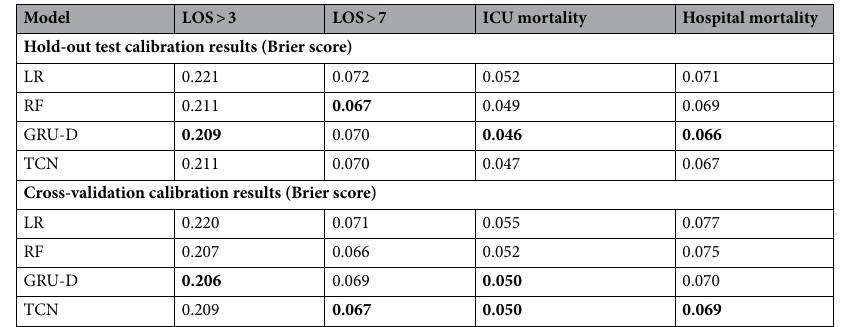
Table 3. Model calibration comparison using Brier scores for both hold-out validation and cross-validation. Inner-task comparison demonstrates similar (or stronger) calibration of TCN to baseline models. TCN, temporal convolution network; GRU-D, gated recurrent unit with delay; RF, random forest; LR, logistic regression; LOS, length of stay. Best-in-task values are in